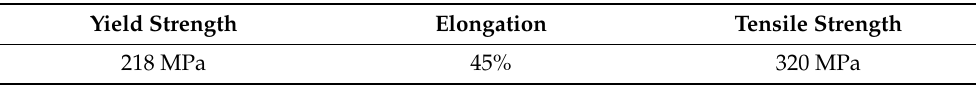
Table 1. Mechanical properties of pure titanium (JIS H 4600 TR270C).